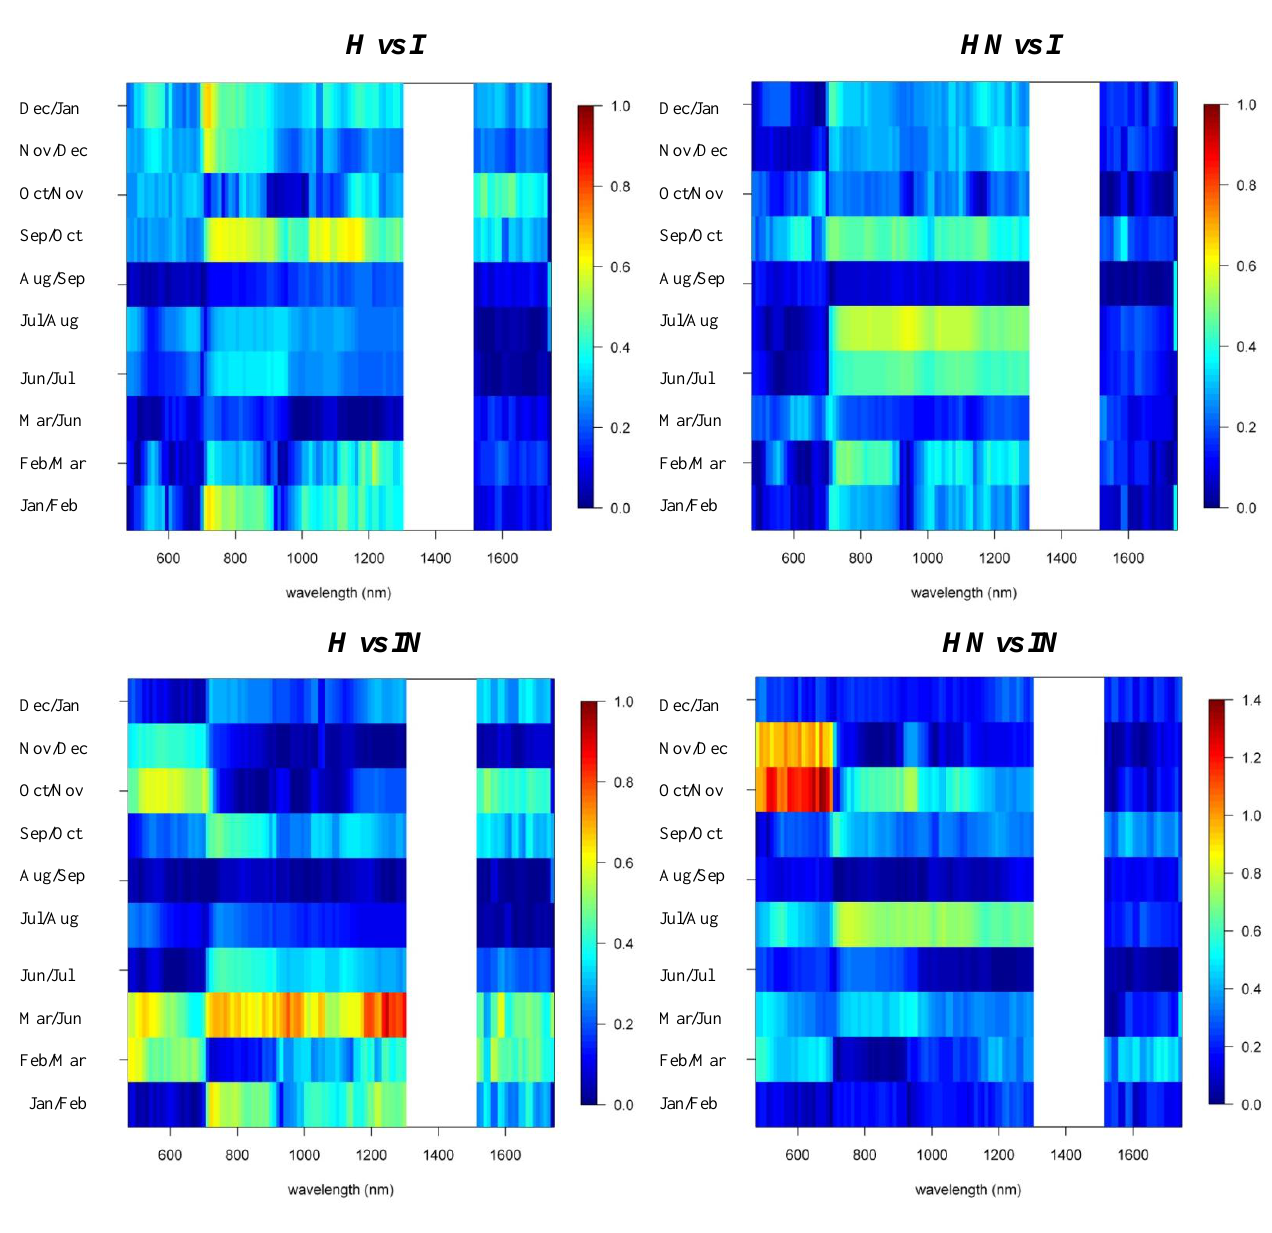
Figure 4. Spectro-temporal SI charts for the pairwise species comparisons of the temporal displacement spectra ( i.e. , temporal derivatives or the change in reflectance between two consecutive time